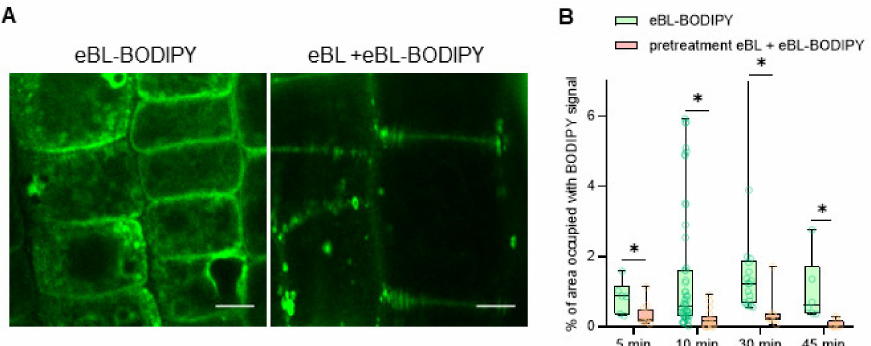
Figure 2. eBL-BODIPY internalizes into root epidermal cells. ( A ) Representative images of root epidermal cells after 30 min exposure to 10 µ M of eBL-BODIPY (left panel: non-pretreated seedlings, right panel: seedlings pretreated for 60 min with 1 µ M eBL), scale bars 5 µ m; ( B ) quantification of the intracellular fluorescence in root epidermal cells exposed to 1 µ M eBL-BODIPY for different time, n ≥ 20; * indicates significant differences between treatments within one sampling point, p < 0.05, t -test.